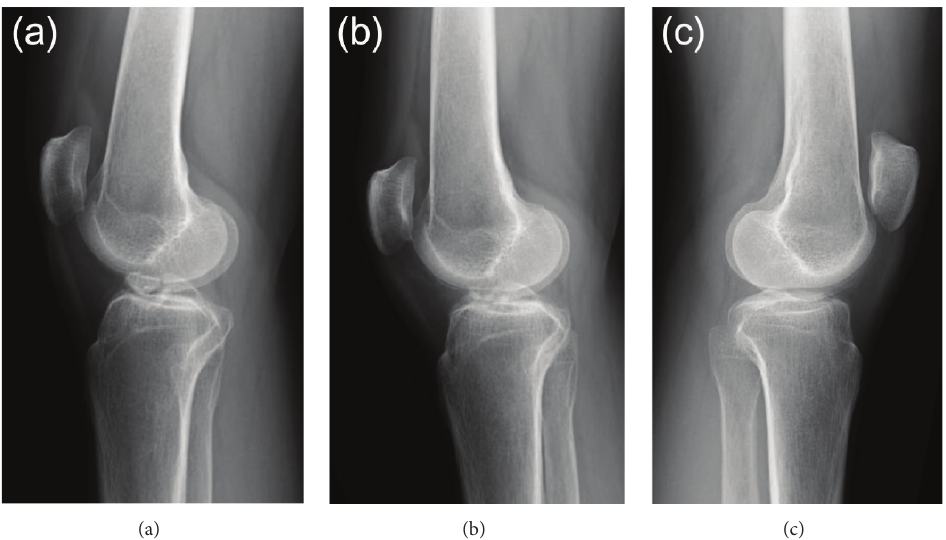
Figure 1: Plain radiography of our patient. (a) Lateral view of the right knee joint on first examination at our hospital, showing complete displacement of the avulsed fragment at the right anterior tibial eminence from the tibial bone mass and impingement of the fragment on the femoral intercondylar notch during knee extension. (b) Lateral view of the right knee joint 2 years after resection of the anterior region of the avulsed fragment at the anterior tibial eminence, showing no impingement of the avulsed fragment on the femoral intercondylar notch during knee extension. (c) Lateral view of the left knee joint at the time of initial examination at our hospital.